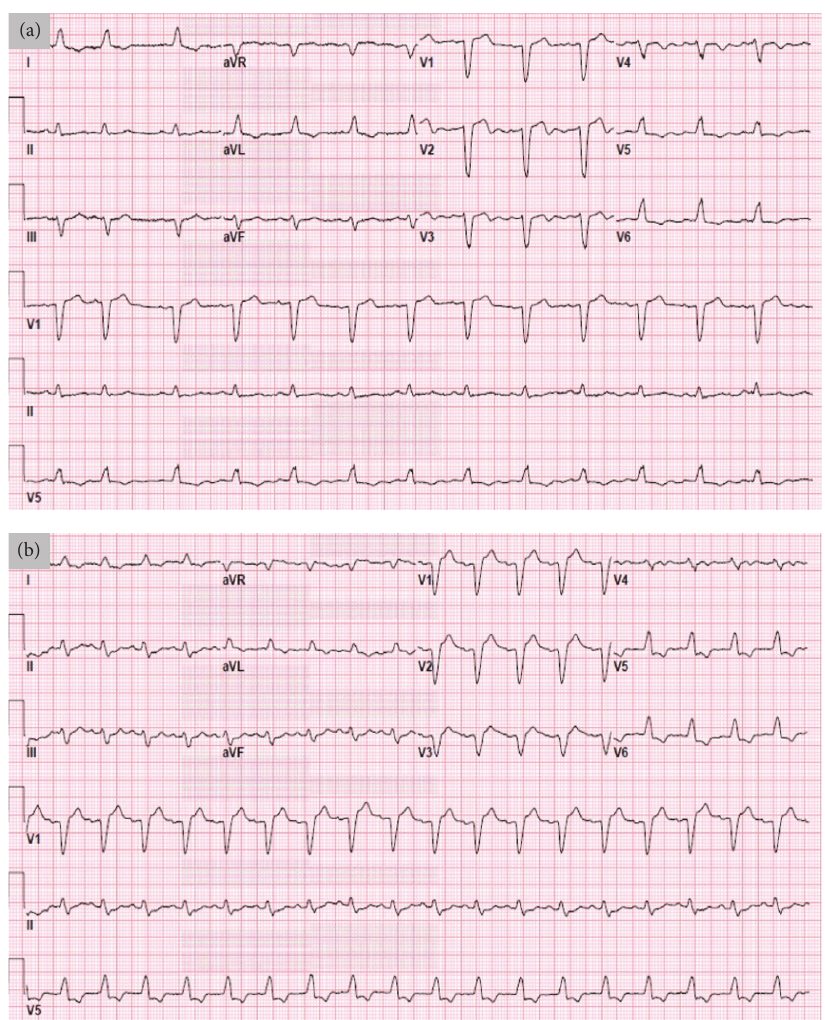
Figure 1: (a) Initial 12-lead ECG after removal of foreign body showing sinus rhythm, LBBB, and one supraventricular premature complex. (b) Second 12-lead ECG showing sinus tachycardia, the same LBBB, and new ST depressions in II, III, and aVF, as well as more prominent ST depression in V5 and V6 in the setting of